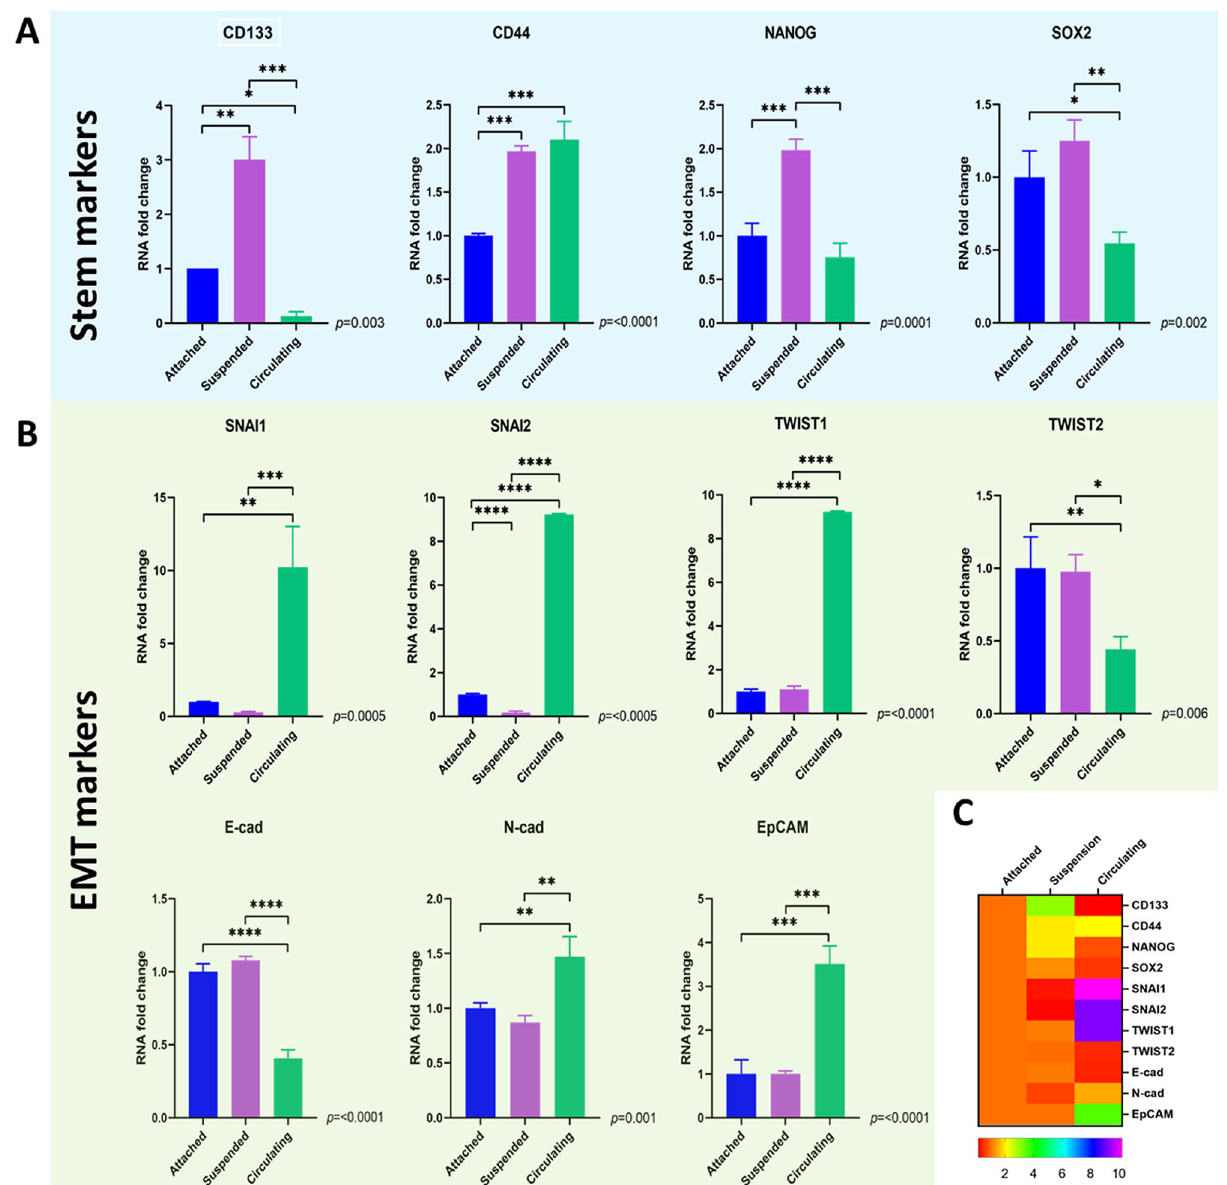
Figure 4. Lung cancer cells adopt a specific stem and EMT marker expression in response to circulation that is independent of a loss of adherence. The expression of stem makers and EMT expression in primary cancer cells in circulation, adherence, and suspension were assessed by qPCR. ( A ) Cells able to survive circulation downregulated stem markers CD133, NANOG and SOX2 but upregulated stem cell marker CD44 as compared to adherent cancer cells. Cells in suspension as compared to circulating cancer cells upregulated stem makers CD133, SOX2, NANOG but not CD44. ( B ) Cells able to survive circulation upregulate EMT markers N-Cad, EpCAM, SNAI1, SNAI2, and TWIST1, but down regulate TWIST2 and E-Cad as compared to attached cells and cells in suspension. SNAI2 was downregulated in cells in suspension as compared with attached and circulating cells. No significative differences were found in the expression of SNAI1, TWIST1, TWIST2, E-Cadherin, N-Cadherin and EpCAM as compared with attached cells. Thus, in response to circulation these primary lung cancer cells adopt a unique stem cell profile and EMT state to survive circulation that is independent of a loss of adherence. ( C ) Heatmap. Comparison of gene expression between experimental stemness 49 . To analyze the effect of CSS on the clonogenicity of cancer cells, CFAs were performed. No significant differences were found in the number of colonies between CSS and attached cells (Fig. 6B,C). These experiments show that circulation leads to enrichment of cells with side population characteristics that do not have clono- genicity, supporting that they are not stem like cells.